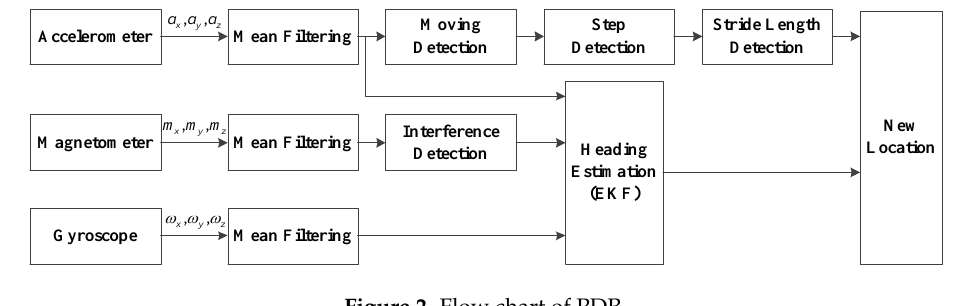
Figure 2. Flow chart of PDR.